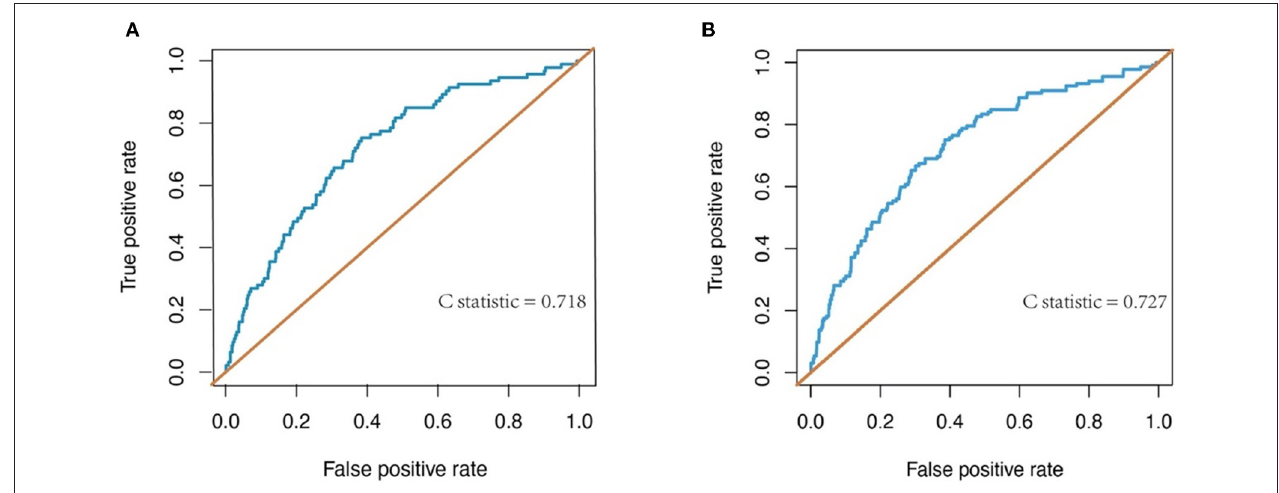
FIGURE 3 | Receiver-operating characteristic (ROC) curve for evaluating the discrimination performance of the model in both the training and validation cohorts. (A) ROC curve to evaluate discrimination performance in the training cohort; C-statistic was 0.718. (B) ROC curve for evaluating discrimination performance in the validation cohort; C-statistic was